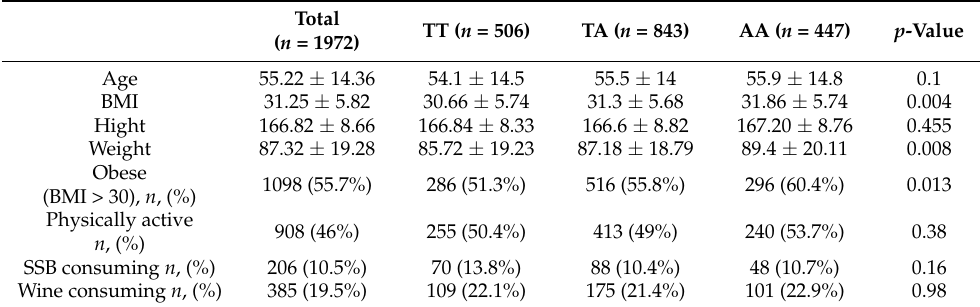
Table 3. FTO rs9939609 SNP population characteristics.